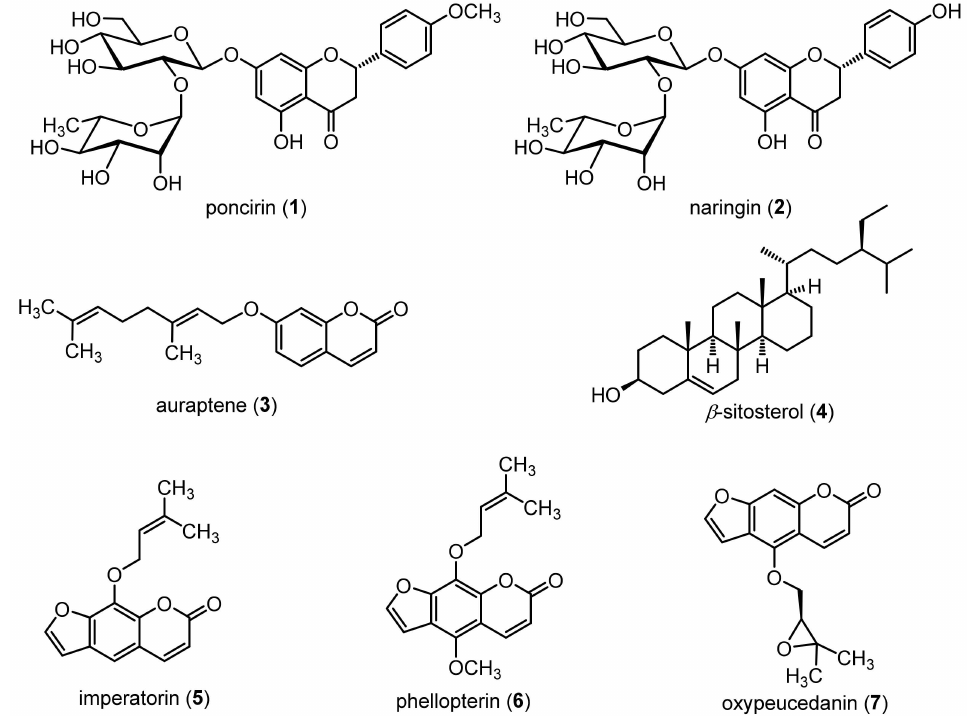
Figure 1. Structures of isolated